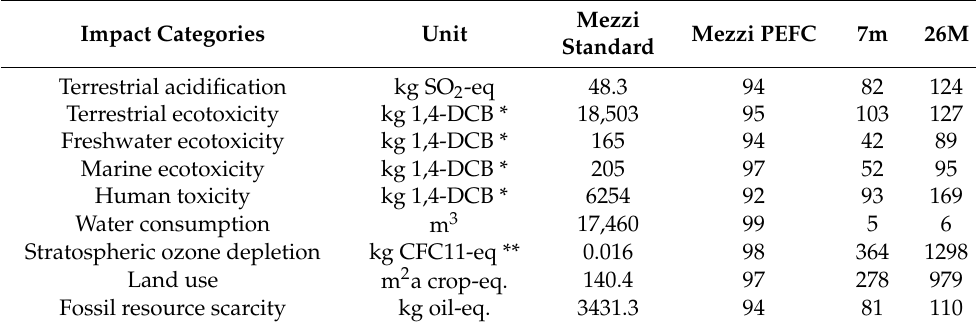
Table 1. Comparison (in %) between the environmental results per functional unit from the “Mezzi” standard and the remaining cropping systems under assessment.